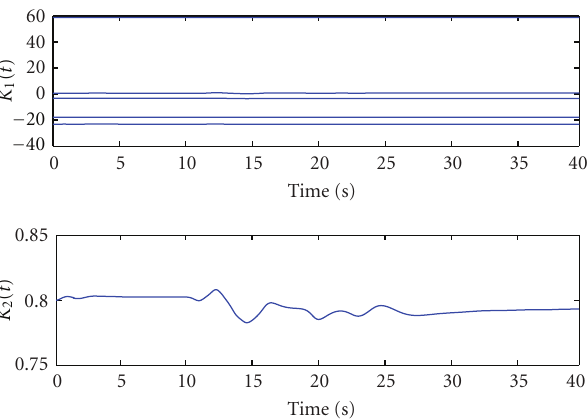
Figure 4: Time history of controller parameters (Case 1).